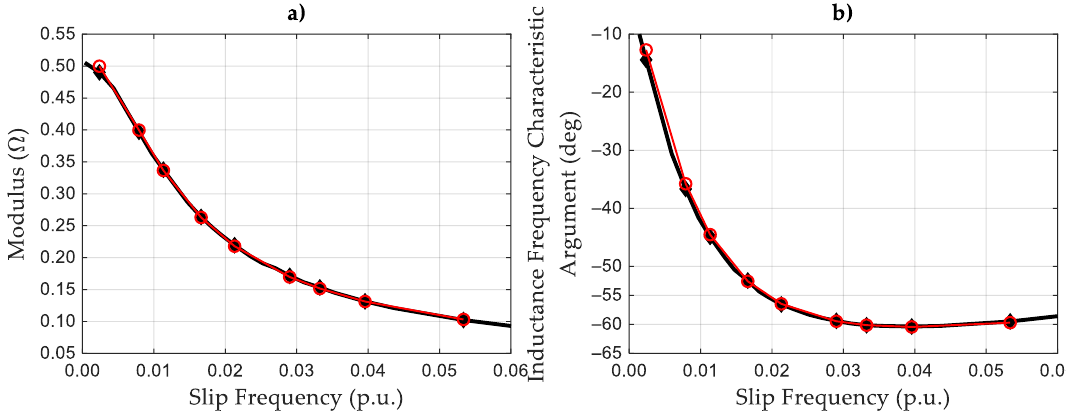
Figure 5. The inductance frequency characteristic determined based on the data derived from the LCT performed ex- perimentally and its approximation by means of the IM mathematical model: ( a ) modulus and ( b ) argument.